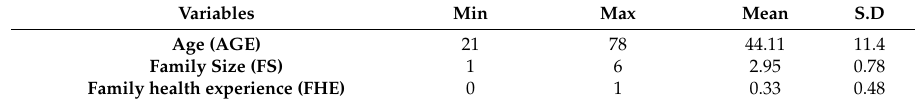
Table 1. Descriptive statistics for the observed exogenous